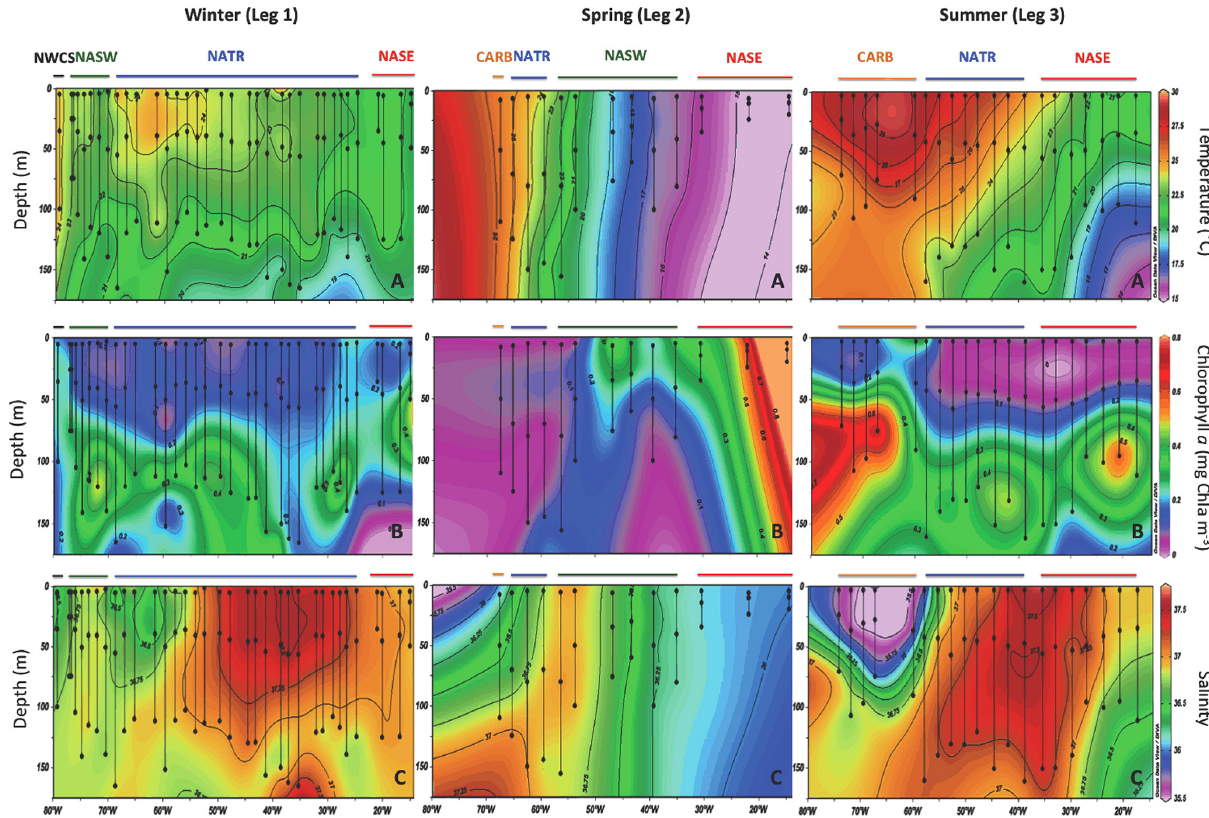
Figure 2. Contour plots for (a) temperature ( ◦ C), (b) chlorophyll a (mgChl a m − 3 ) and (c) salinity of the profiles sampled (black lines) in Leg 1–winter, Leg 2–spring and Leg 3–summer. Black points indicated the three sampled depths (surface, 20% PAR and DCM) in each